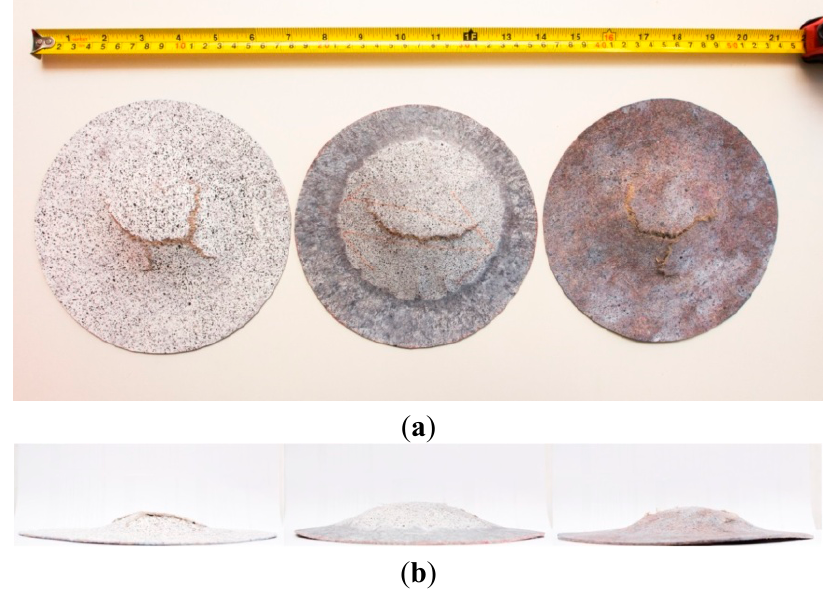
Figure 7. Images of the untreated, saturated and dried CNFC (from left to right) after stamp forming experiments from, ( a ) top view; and ( b ) front